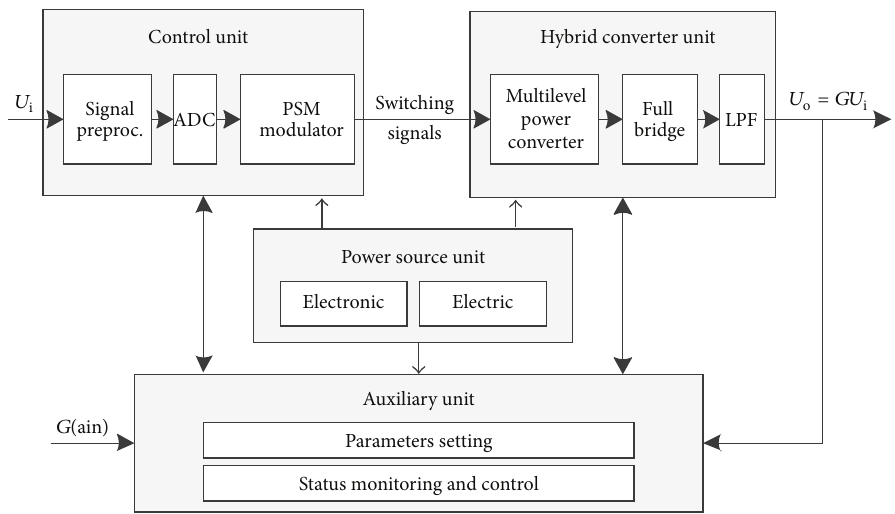
Figure 1: Block diagram of high-voltage switching